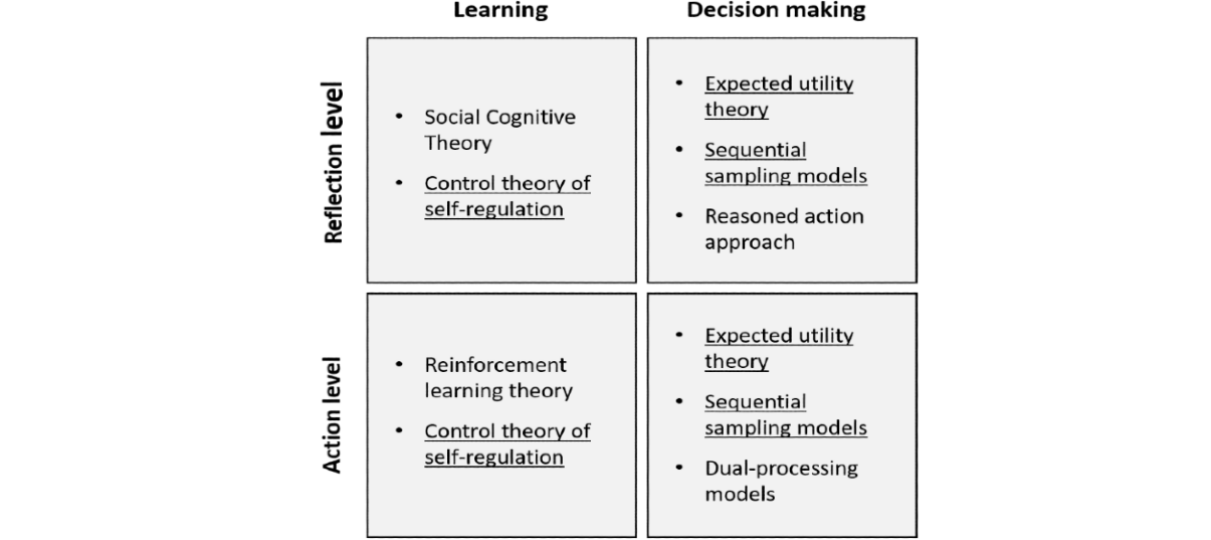
Figure 2. Categorization of reviewed theories based on their theoretical traditions and temporal scales (theories that apply to both temporal scales are